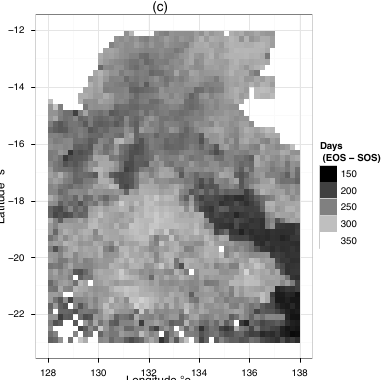
Figure 4: Spatial patterns of 11 years (2000-2011) mean LOS (the length of growing season) in the NATT. Origi- nal 0.05 degree resolution result had been aggregated to 0.2 degree resolution for plotting purpose.